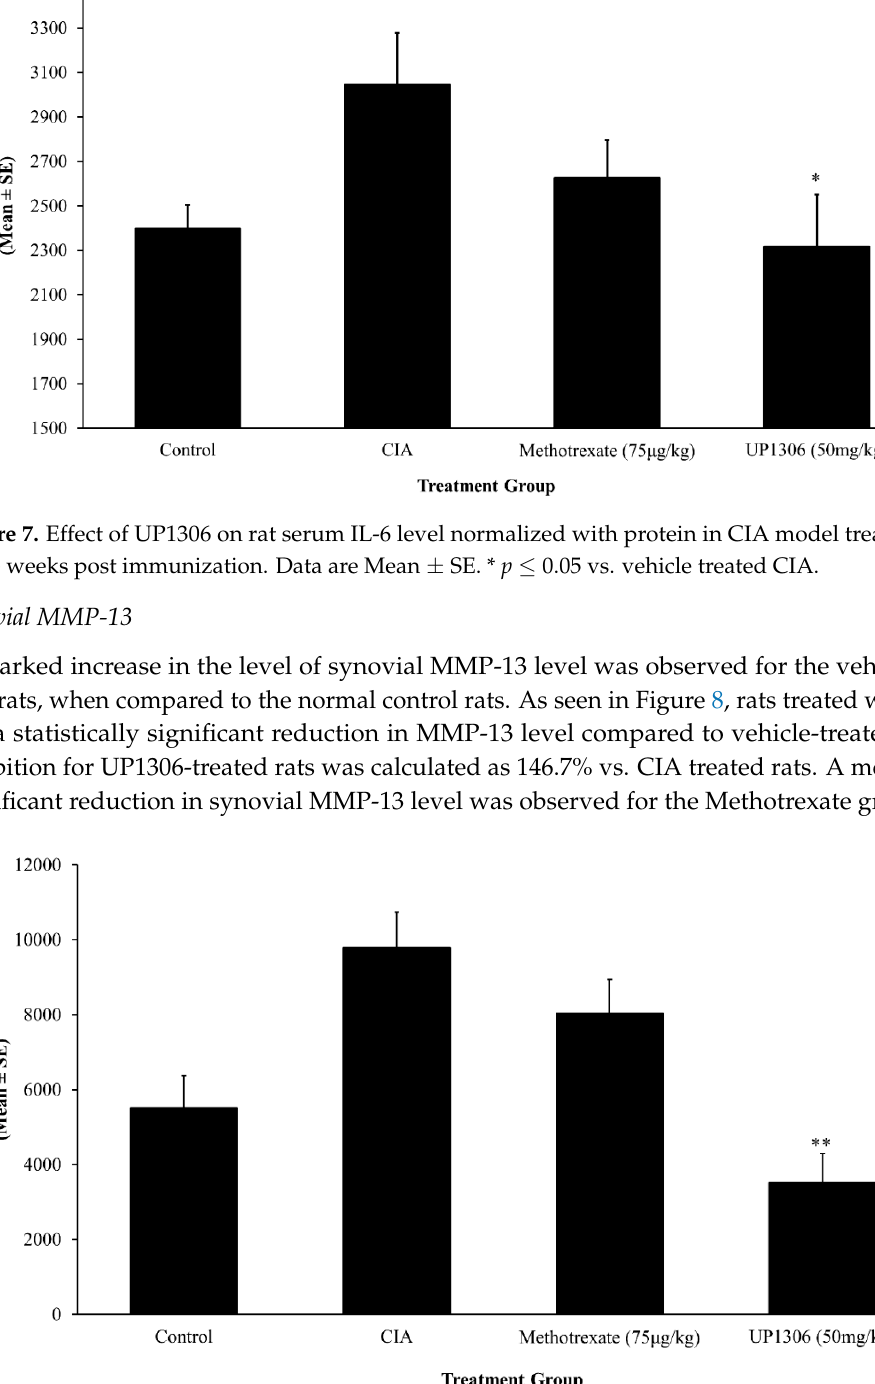
Figure 6. Effect of UP1306 on rat serum tumor necrosis factor α (TNF ‐α ) level normalized with protein in CIA model treated for three weeks post immunization. Data are Mean ± SE. * p ≤ 0.05 vs. vehicle treated CIA.